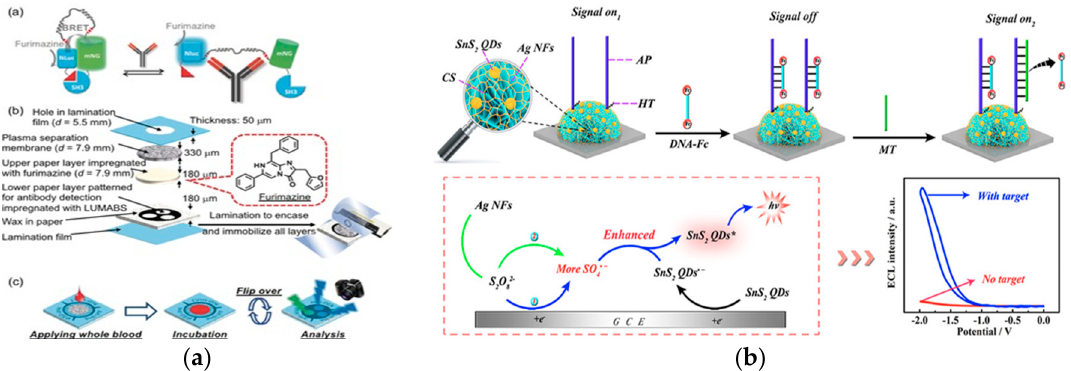
Figure 9. ( a ) Top: schematic of green light-emitting luminescent antibody-sensing proteins (LUMABS) in the absence of target antibody and blue light-emitting LUMABS in the presence of antibody. Middle: schematic of a microfluidic paper-based analytical device. Bottom: schematic of detection of three separate antibodies using a single device. (Adapted from Ref. [64]. Copyright © 2018, The Authors, published by Wiley-VCH Verlag GmbH & Co. KGaA.) ( b ) Top: schematic of the SnS2 quantum dots and Ag nanoflowers ternary structure on the glassy electrode and subsequent signal o ff and on mechanism. Bottom: Proposed ECL mechanism of the system. (Adapted with permission from Ref. [65]. Copyright 2018 American Chemical